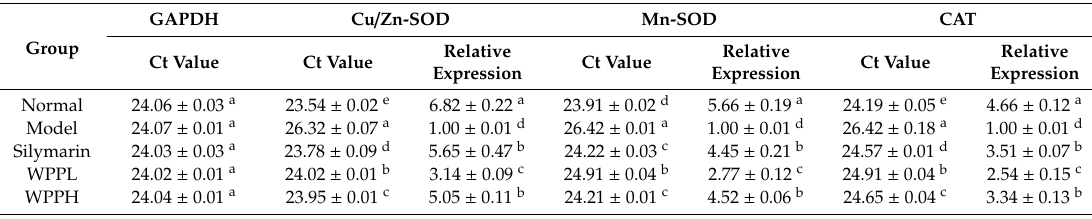
Table 7. Cu–Zn superoxide dismutase (Cu-Zn-SOD), Mn-SOD, and catalase (CAT) mRNA expression in the hepatic tissues of the mice ( N = 10).